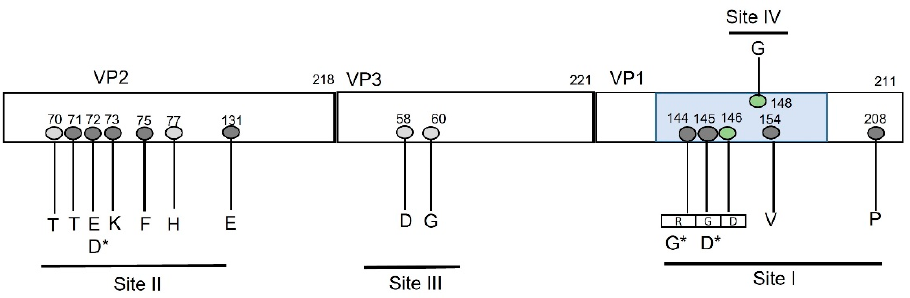
Figure 2. Comparison of antigenic sites of FMDV serotype A and their evolution under natural